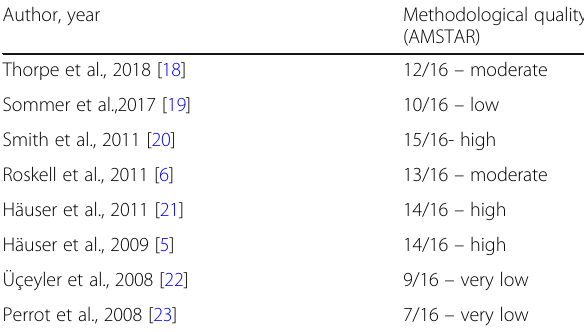
Table 3 Methodological quality of the systematic reviews included in the